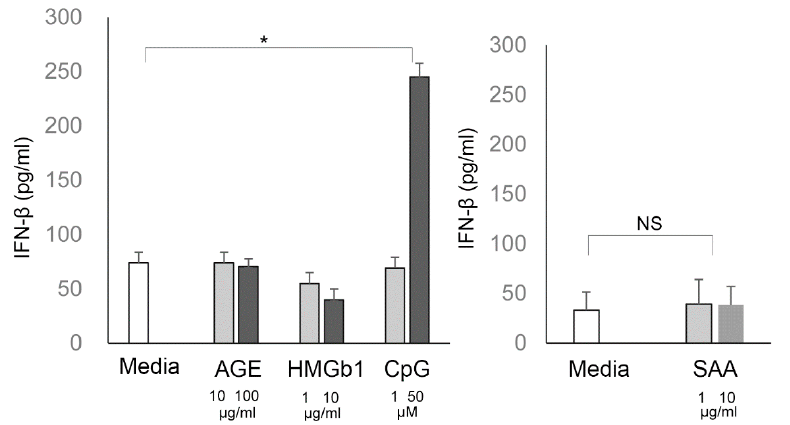
Figure 1. Responsiveness of human corneal endothelial (HCEn) cells to the receptors of advanced glycation end products (RAGE) ligands assessed by the level of expression of interferon- β . Exposure to CpG DNA significantly induces interferon- β expression after 12 h (left). Advanced glycation end products (AGE), HMGB1, and serum amyloid A (SAA) (right) do not significantly induce interferon- β . DMEM with 10% FBS was used for the assay media. Left and right panels were obtained from different batches of cells of single origin. For * p < 0.00001; n = 6. Ns: not significant. HSV-1 is the most common pathogen causing corneal endothelial inflammation [17], and the HSV-1 genome contains CpG DNA sites [18]. Therefore, we hypothesized that